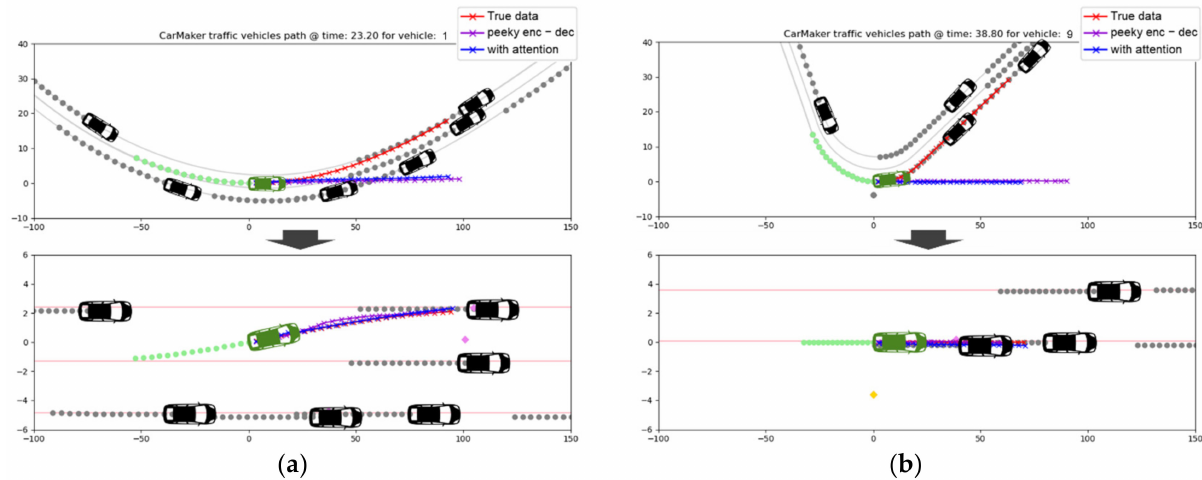
Figure 12. Trajectory prediction with simulation data: ( a ) lane changing and ( b ) lane